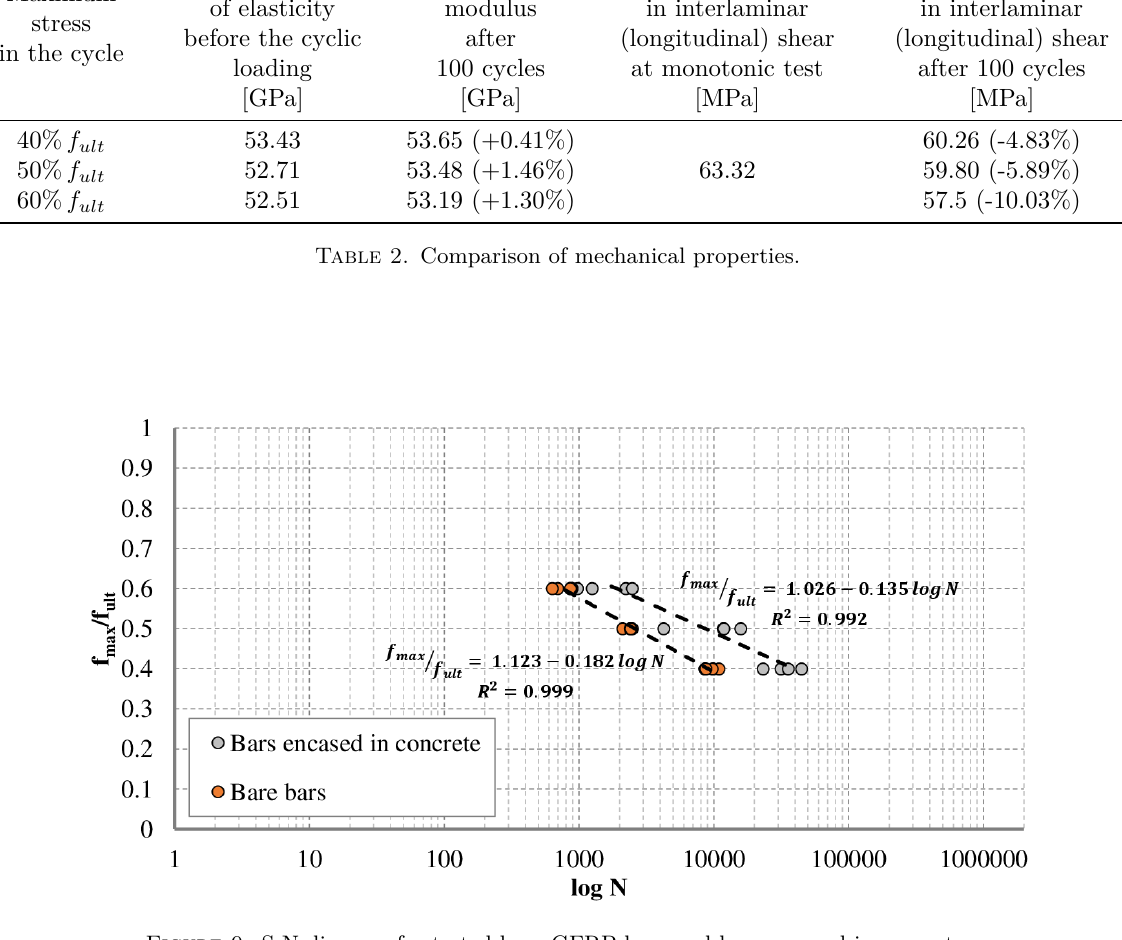
Figure 9. S-N diagram for tested bare GFRP bars and bars encased in concrete.